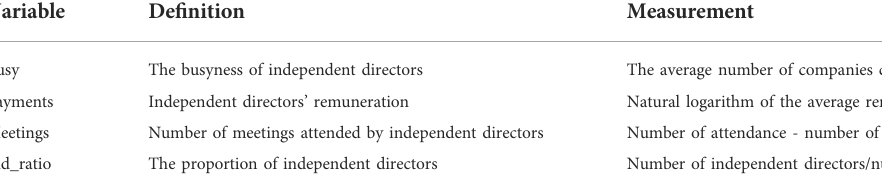
TABLE 6 Effectiveness of independent directors ’ performance.